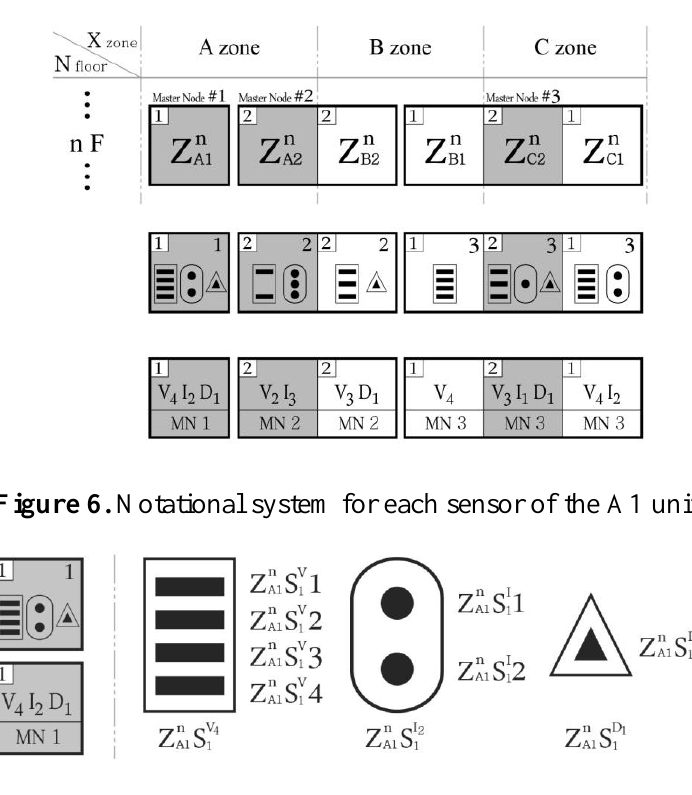
Figure 5. Method for conversion.